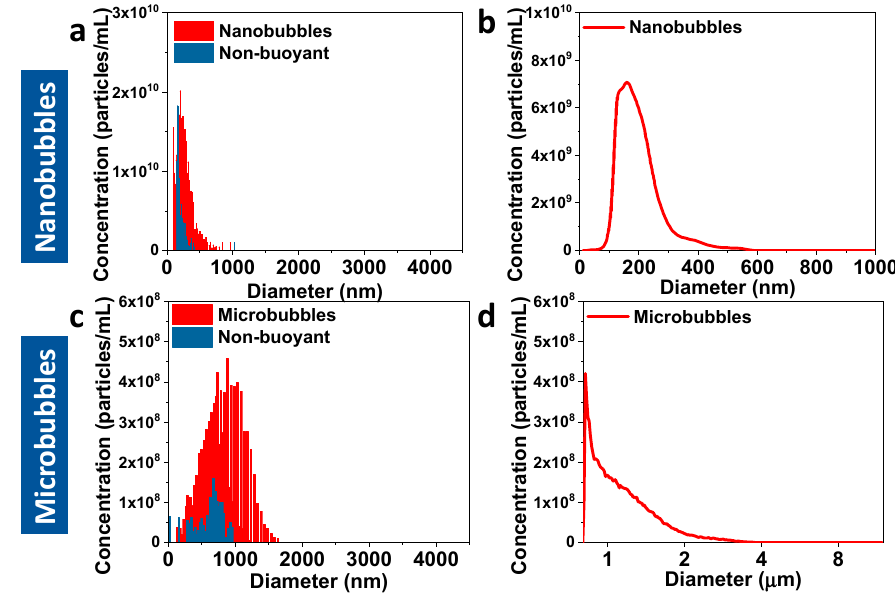
Figure 1. Nanobubbles and microbubbles were characterized using different techniques: ( a , c ) resonant mass measurement (RMM), ( b ) nanoparticle tracking analysis (NTA), and ( d ) Coulter counter.